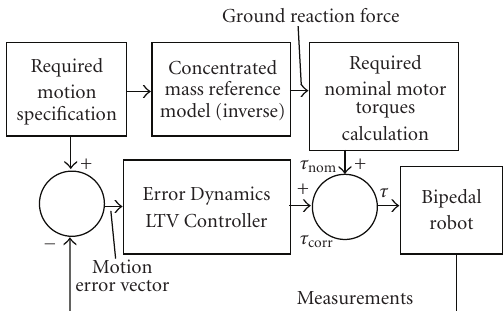
Figure 3: Control system based on the torque prediction using the concentrated mass reference model, τ nom is the nominal torque vector calculated based on the ground force provided by the reference model (mass-spring model), τ corr is the correction calculated based on the measurements of the robot joints angles and acceleration vector, and τ is the commanded torque signal that is sent to the